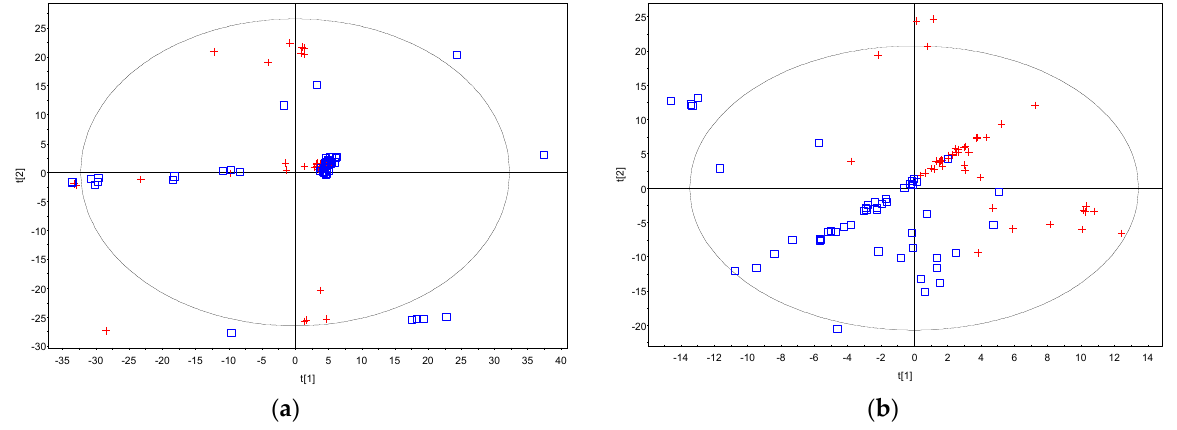
Figure 1. Principal component analysis and partial least square discriminant analysis. ( a ) Principal component analysis (PCA) loadings plot showing partial clustering of the control group (blue square) and the VPA treatment group (red cross); ( b ) partial least square discriminant analysis (PLS − DA) loadings plot showing clustering of the control group (blue square) and the VPA treatment group (red cross).